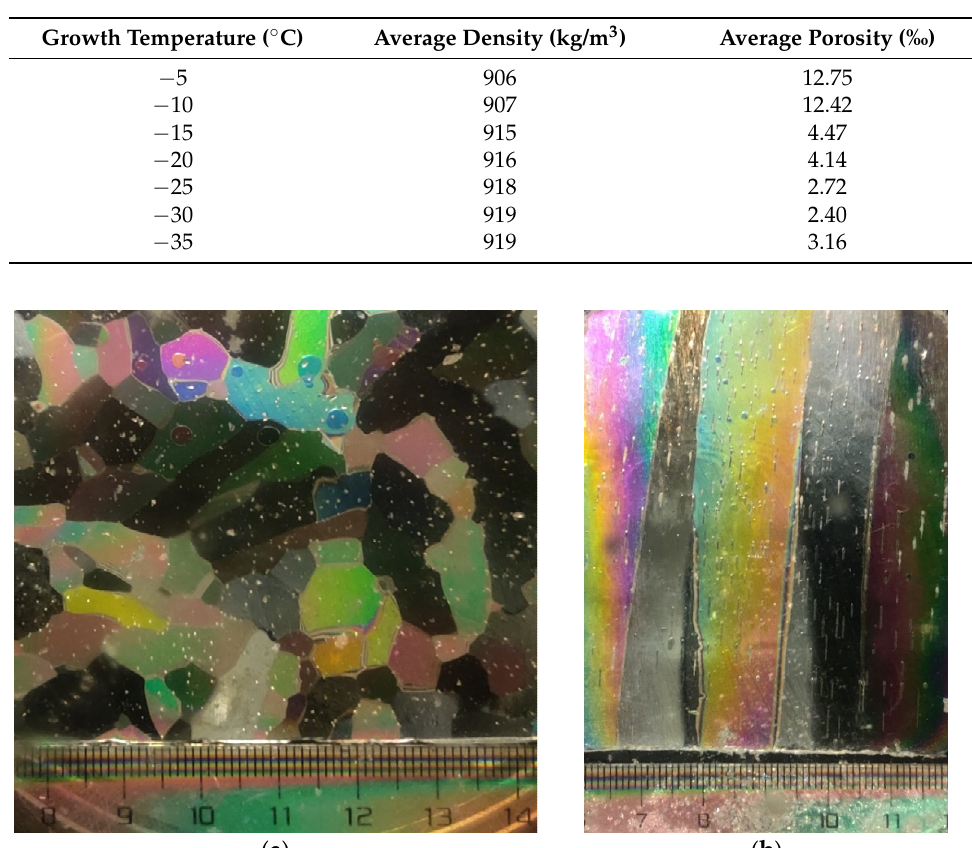
Table 2. Measured average density and porosity of ice samples at different growth temperatures.